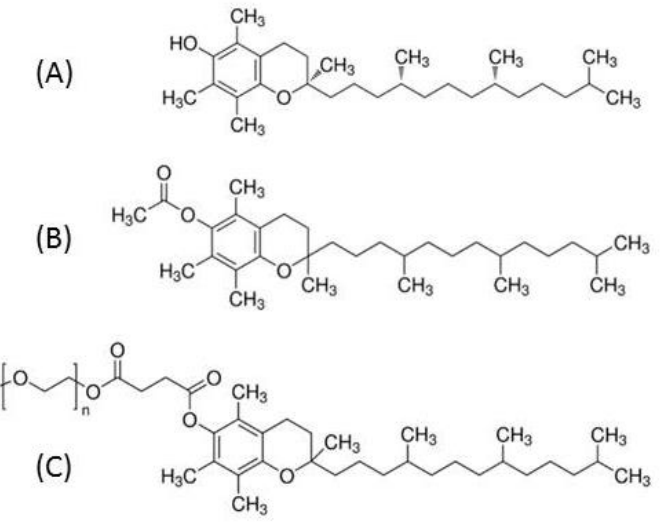
Figure 1. Schematic representation of tocopherol and its esterified derivatives; ( A ): α-Tocopherol, ( B ): α-Tocopherol acetate, ( C ): α-Tocopherol polyethylene glycol succinate 1000 (TPGS - n =23).